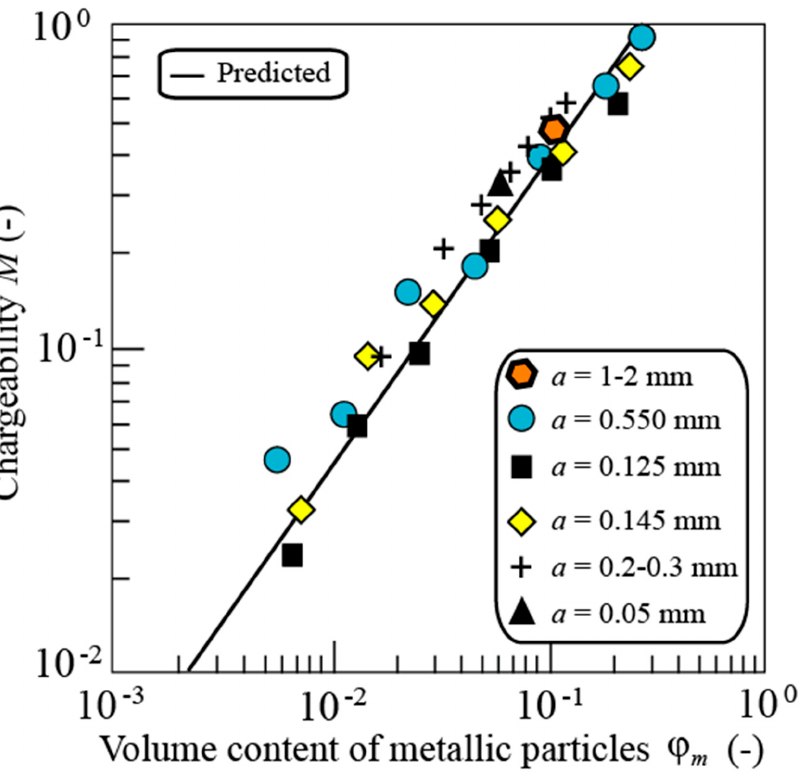
Figure 13. Total chargeability versus pyrite content. Comparison between the prediction of the linear relationship (plain line) and the experimental data from Gurin et al. (2013) [70] (filled symbols except the triangle), Pelton et al. (1978) [11] (crosses), and Mahan et al. (1986) [65] (triangles). In the first case, the ore is a mixture of (by volume) pyrrhotite (30%), pyrite (30%), magnetite (30%), and chalcopyrite (10%). The sample with the pyrite grains that are from 1 to 2 mm in radius is from Phillips (2010) (pyrite, sample K01, sericite quartz, 10% vol. pyrite) [82]. In the second case, the metallic grains correspond to pyrite. The chargeability is expressed as a function of the volume content of the metallic particles ( ϕ m ). This relationship is independent of the grain radius ( a ) of the metallic particles, as predicted by the model. For this dataset, the background porous material is characterized by a low chargeability, and so we are in the case that is described in Section 3. Modified from